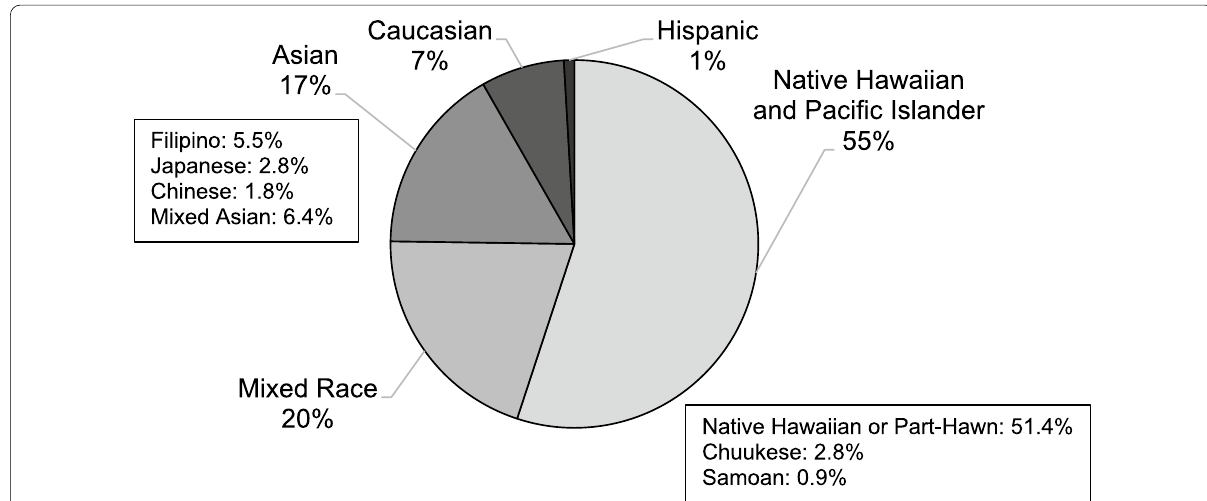
Fig. 2 Research Experiences in Marine Science (REMS) Program Participant Ethnicities. Self-reported ethnicities of total participants ( N response to an open-ended question on program applications. Racial categories reflect those used by the University of Hawai ʻ i (UH) System as per UH race and ethnicity reporting protocols: http:// manoa. hawaii. edu/ miro/ wp- conte nt/ uploa ds/ 2014/ 07/ Race- Ethni city- Stude nt- and- Facul ty.